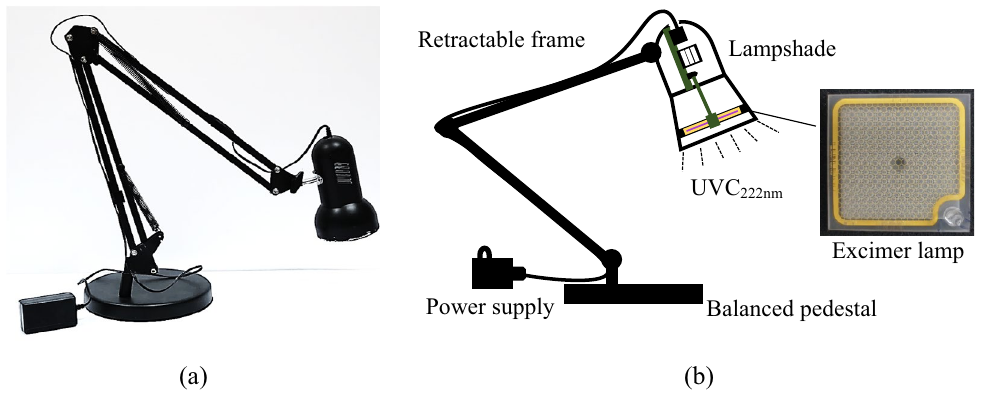
Figure 1. A far-UVC lamp constructed for dining-table disinfection: ( a ) photograph of the exterior appearance; ( b ) diagram of the structure and photograph of an excimer